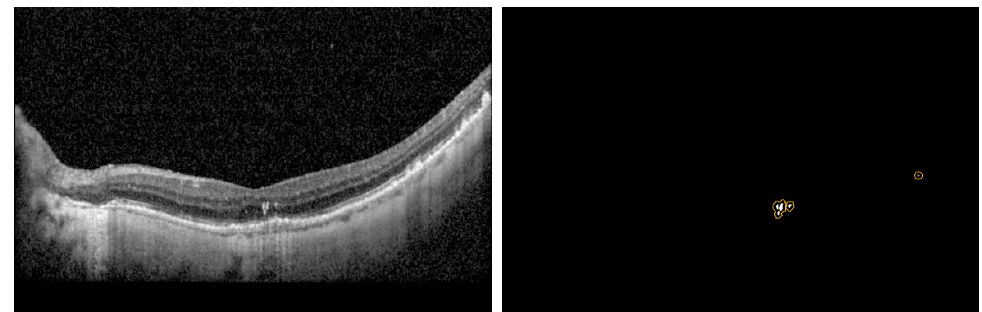
Figure 4. Visualization of prediction with nxn windowing.